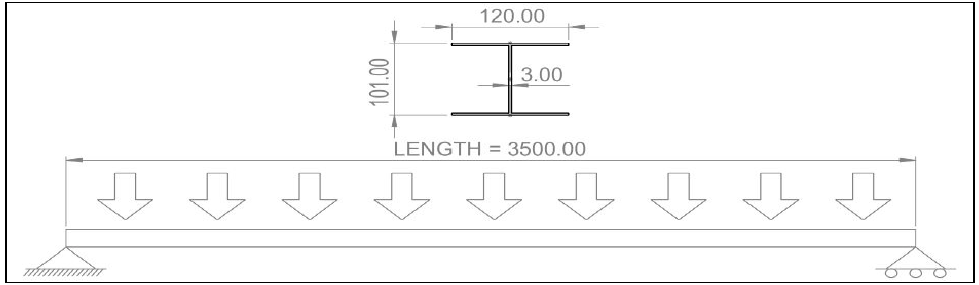
Figure 17. Beam with uniformly distributed loads.